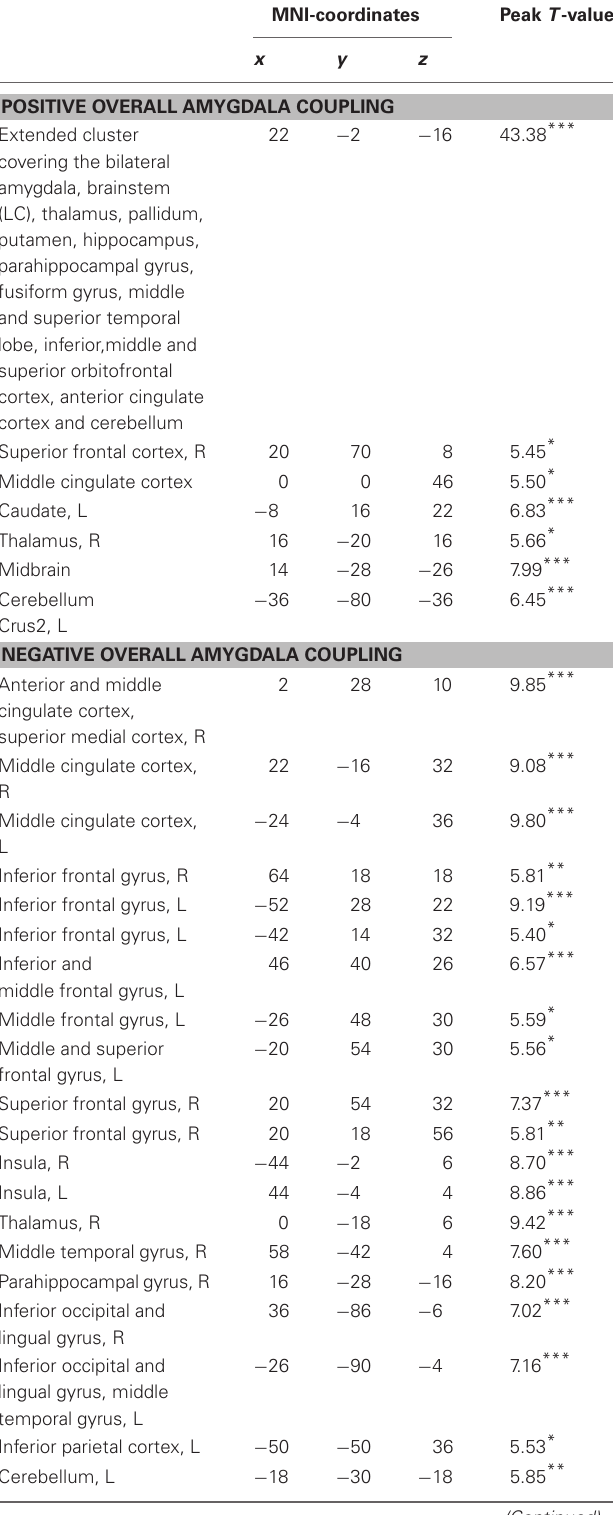
Table 3 | Peak voxels and corresponding T values of significantly activated clusters that show functional coupling with the bilateral